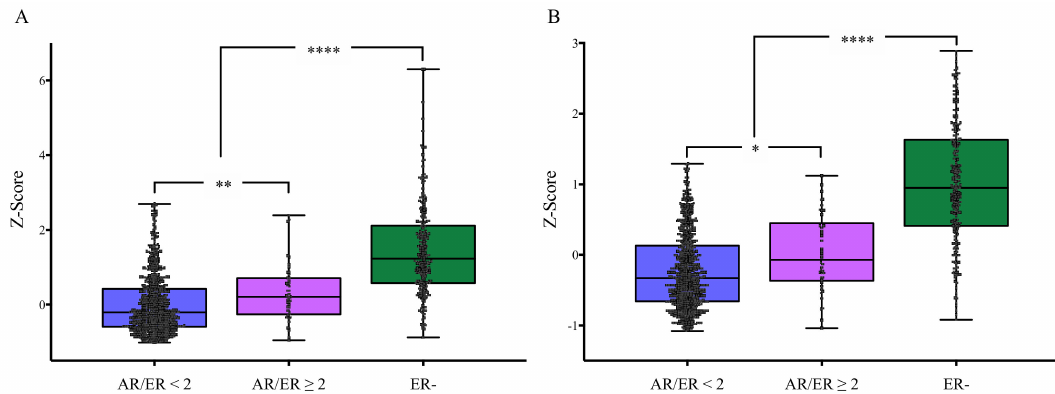
Figure 2. Gene expression cell proliferation signatures (CPSs) of BC cases from GDC, grouped by AR / ER ratio. ( A ) Significantly higher levels of CPS were observed in BC cases with ratio AR / ER greater than 2, using AURKA, BIRC5, CCNB1, MKI67 and UBE2C as gene proliferation markers. ( B ) The same result was observed when AURKb, BUB1B, BUB1, CDK1 and CHEK1 were used, in an independently way, as additional genes to evaluated CPS. A.** P = 0.005211; **** P = 1.17 × 10 − 44 ; B.* P = 0.028; **** P = 3.54 × 10 − 54 ; ER-: estrogen receptor negative cases; Kruskal–Wallis H test - *, **, ****.